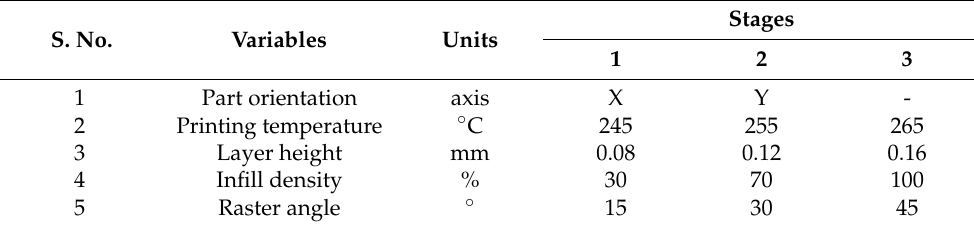
Table 2. Process variables and their various stages.